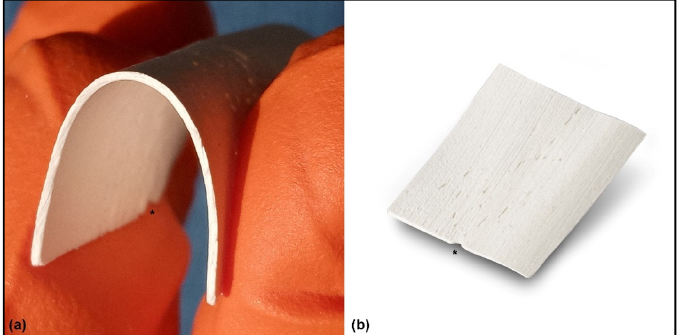
Figure 1. Flex Cortical Sheet: ( a ) Once the FCS was hydrated for a few seconds in a sterile saline solution, the sheet became flexible. ( b ) Appearance of FCS as provided by the manufacturer. A special indentation (*) is placed on one side of the FCS, indicating the direction of the parallel bone fibers and providing an indication to the surgeon about how to fold the FCS, i.e., exert traction forces parallel to the bone fibers.